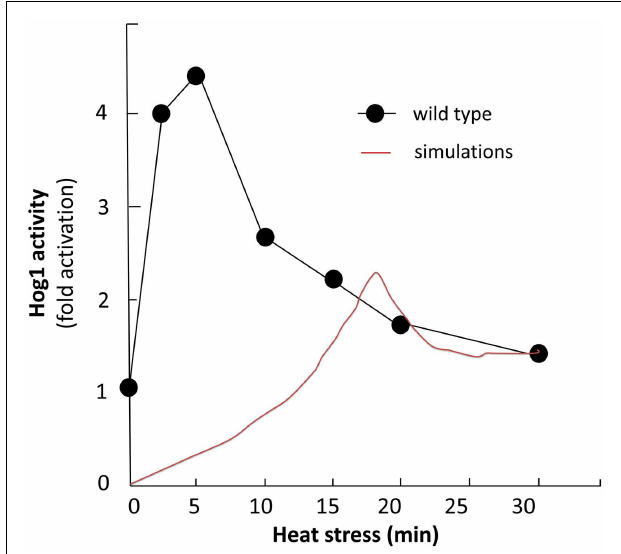
FIGURE 4 | Hog1 study. Comparison of experimental and simulation study. Black curve shows activity of wild type Hog1 upon induction of heat (Winkler et al., 2002) and red curve illustrates Hog1 activation level in continues simulation.